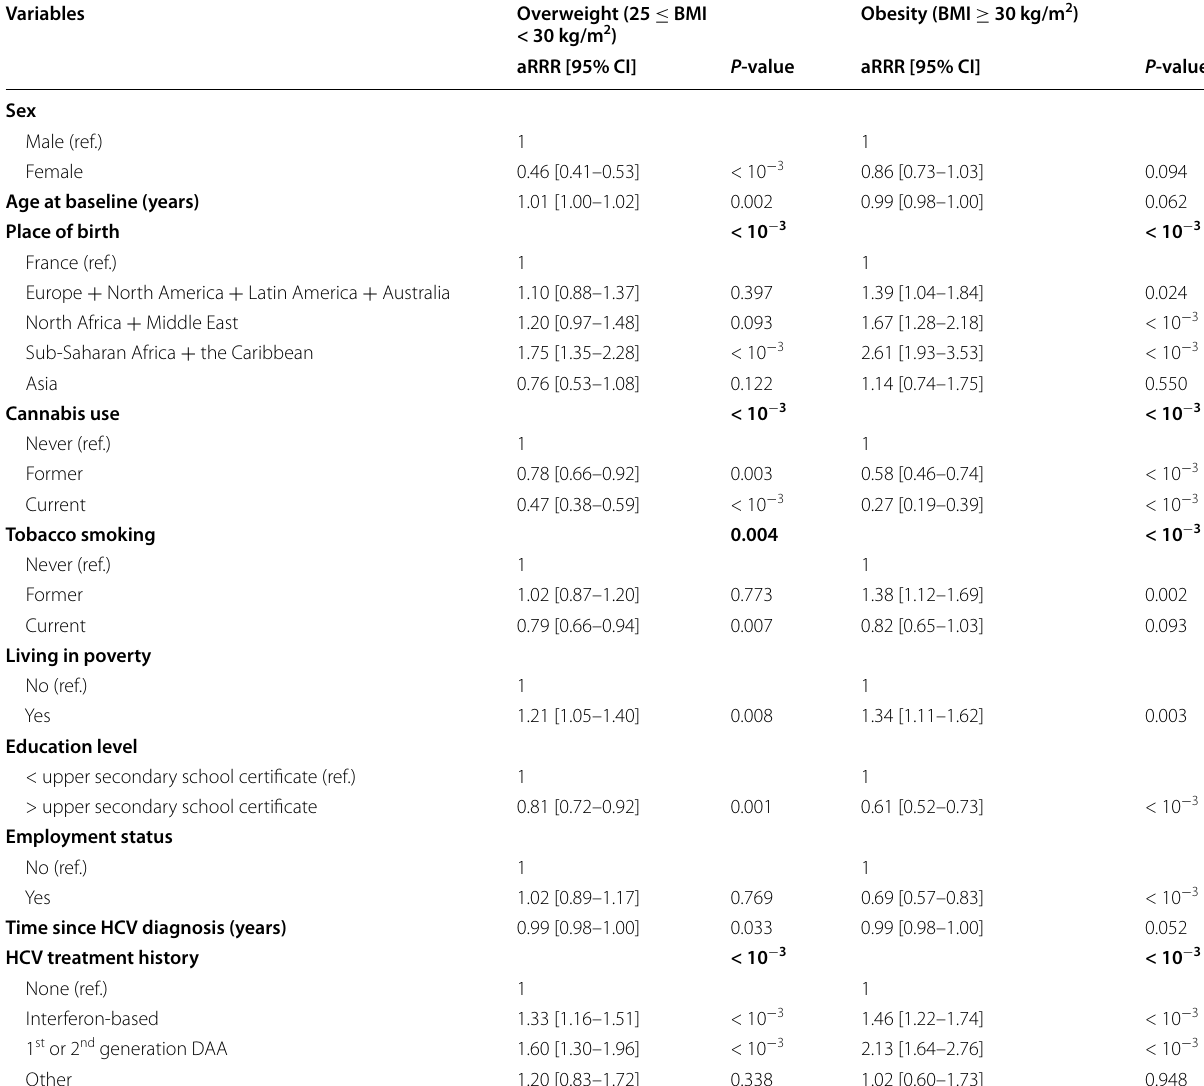
Table 3 Factors associated with overweight and obesity in multivariable analyses (multinomial logistic regression, ANRS CO22 Hepather cohort, N =